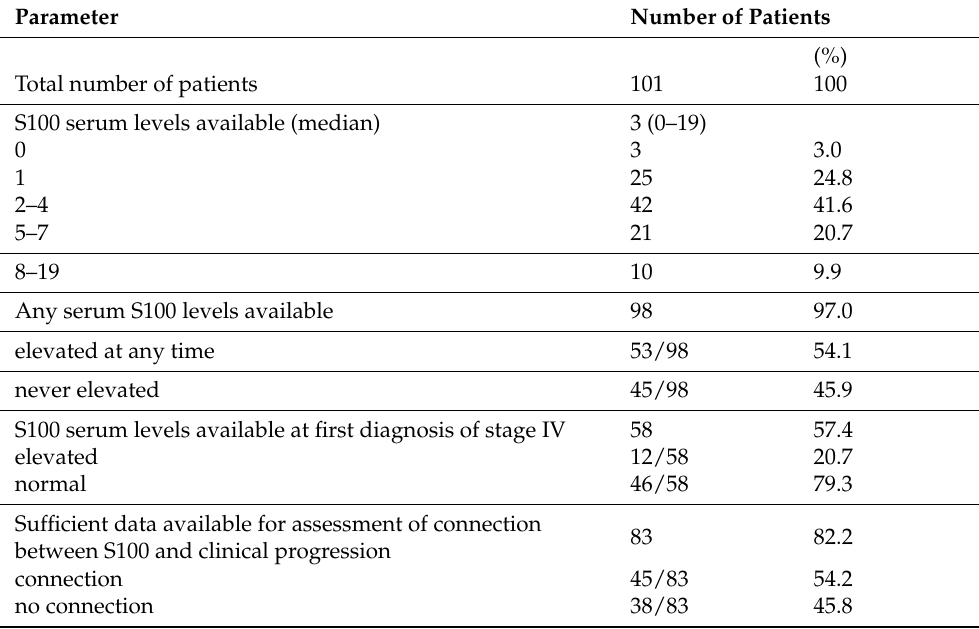
Table 2. Characteristics of S100 serum levels.